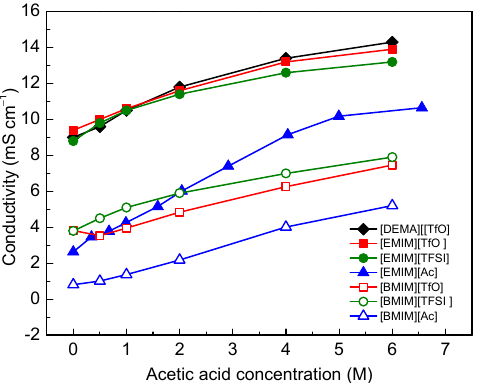
Figure 2. Ionic conductivity as a function of acetic acid concentration in ILs at room temperature.